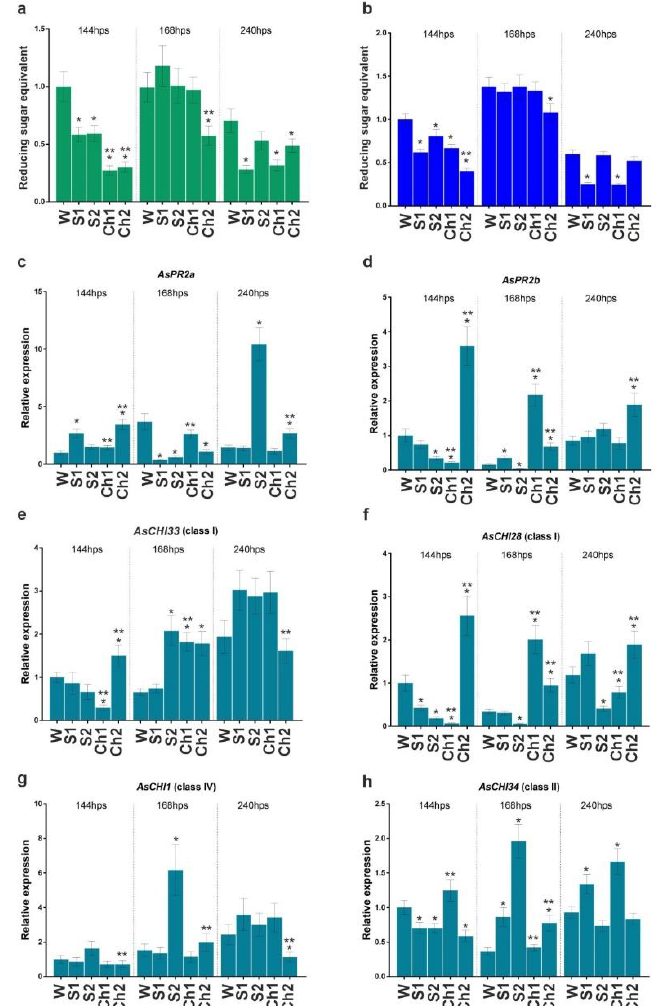
Figure 3. Total chitinase ( a ) and β-1,3-glucanase ( b ) activities and the expression of AsPR2a ( c ), AsPR2b ( d ), AsCHI33 ( e ), AsCHI28 ( f ), AsCHI1 ( g ), and AsCHI34 ( h ) genes in garlic roots at 144, 168, and 240 h post soaking (hps) in water (W), control solutions (S1, S2), and chitosan (Ch1, Ch2). The expression data were normalized to GAPDH and UBQ mRNA levels, statistically analyzed with Graph Pad Prism version 8, and presented as the mean ± SE (n = 3) from three technical replicates of three biological replicates. * p < 0.01, compared to W control; ** p < 0.01, Ch1/2 compared to S1/2.